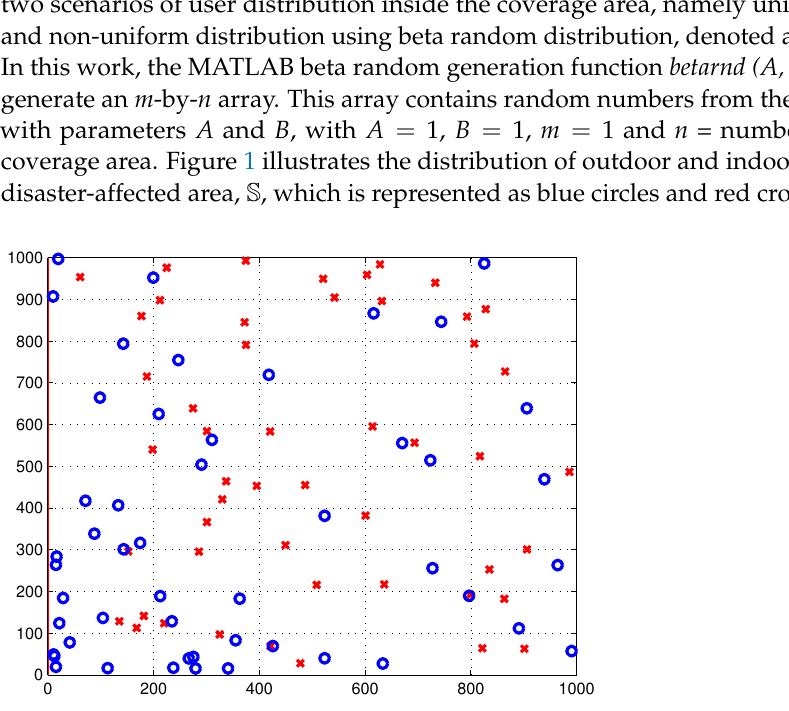
Figure 1. The distribution of outdoor and indoor users inside the disaster-affected area, S